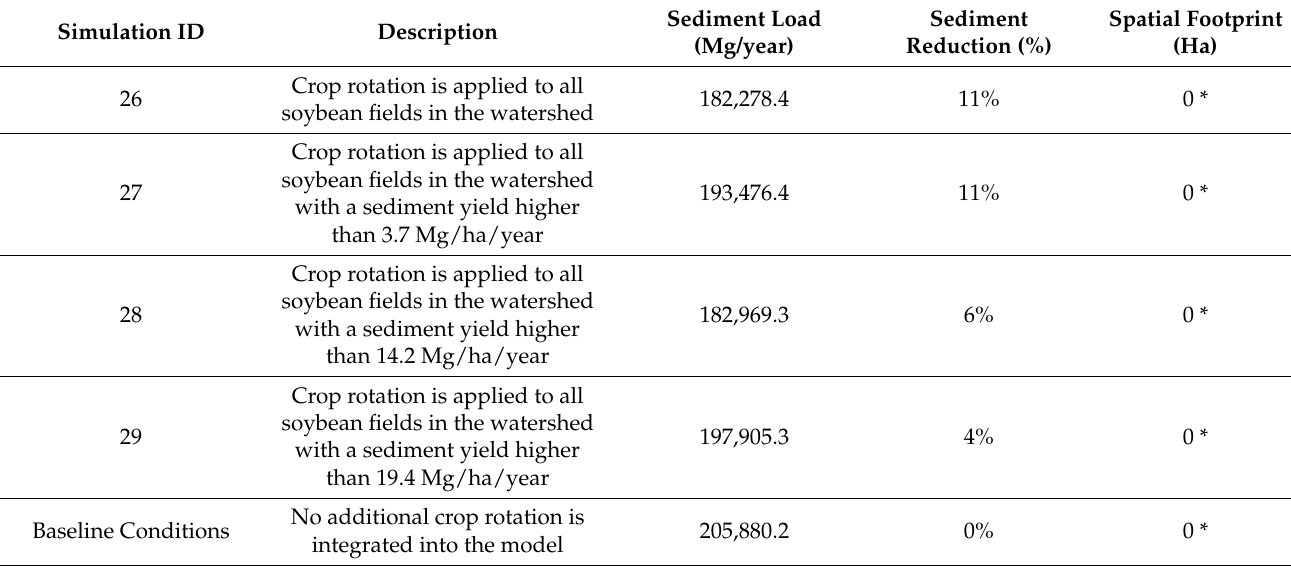
Table 6. Crop rotation scenarios results.